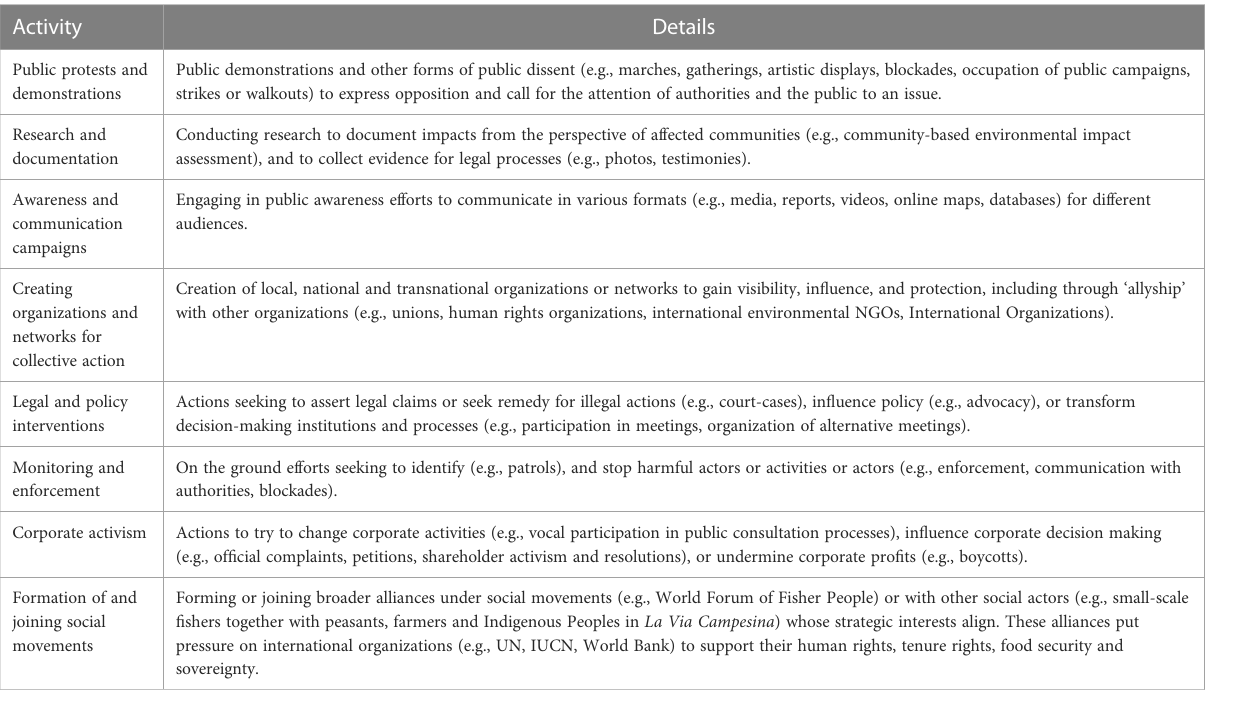
TABLE 1 Examples of activities and actions by ocean defenders to mobilize, oppose and resist threats to their rights.